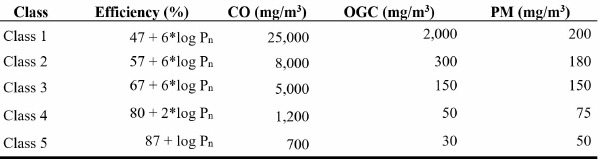
Table 2. Evaluation of biomass boilers up to 50 kW according to the standard STN EN 305-5.